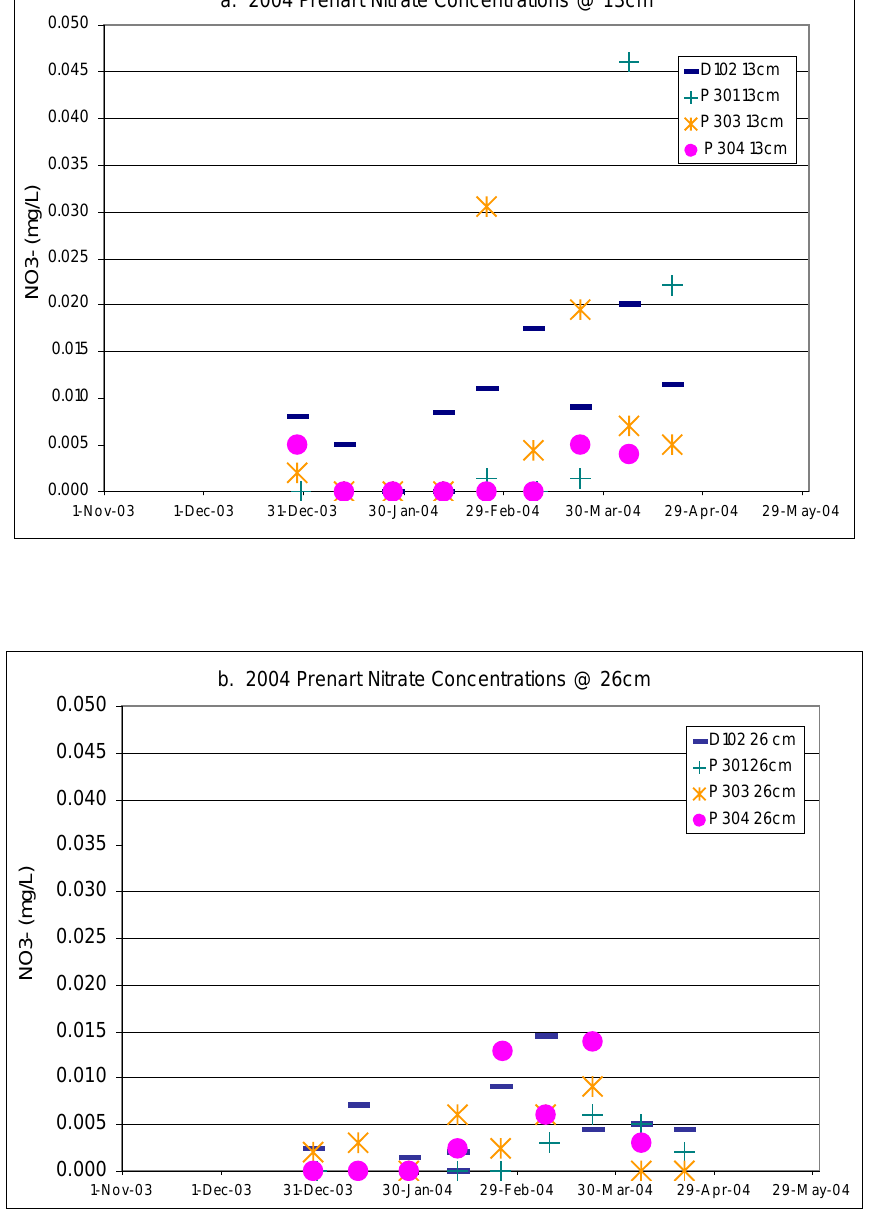
FIGURE 4 . Continuous vacuum lysimeter sampling of soil water at the Providence Site indicates N concentrations in shallow soil water are often below 0.05 mg/l. Values reported are medians. (a) 2004 nitrate concentrations at 13-cm mineral soil depth; (b) 2004 nitrate concentrations at 26-cm depth; (c) 2004 ammonium concentrations at 13-cm depth; (d) 2004 ammonium concentrations at 26-cm depth; (e) 2003 ammonium concentrations at 13-cm depth; (f) 2003 ammonium concentrations at 26-cm depth; (g) 2003 nitrate concentrations at 13-cm depth; (h) 2003 nitrate concentrations at 26-cm